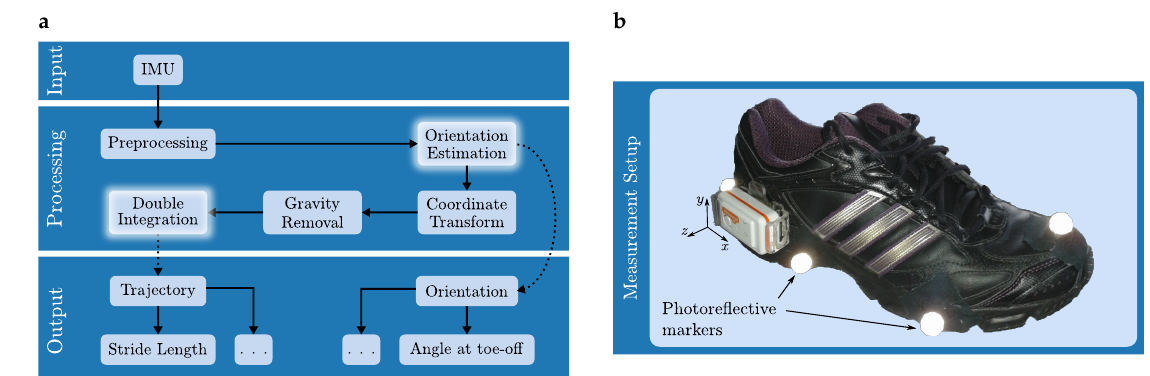
Figure 1. ( a ) Conceptual workflow for estimating foot trajectory and orientation in the context of mobile gait analysis with Inertial Measurement Units (IMUs). Incoming data is processed on a stride-by-stride level in order to provide relevant features as, e.g., stride length or foot orientation at certain key events during the gait cycle. This methodological benchmarking study is specifically concerned with the highlighted blocks; ( b ) An IMU is placed on the lateral side of the shoe below the ankle. The coordinate system of measurement is aligned as indicated above. Additionally, photoreflective markers are attached in order to provide reference data regarding foot position and